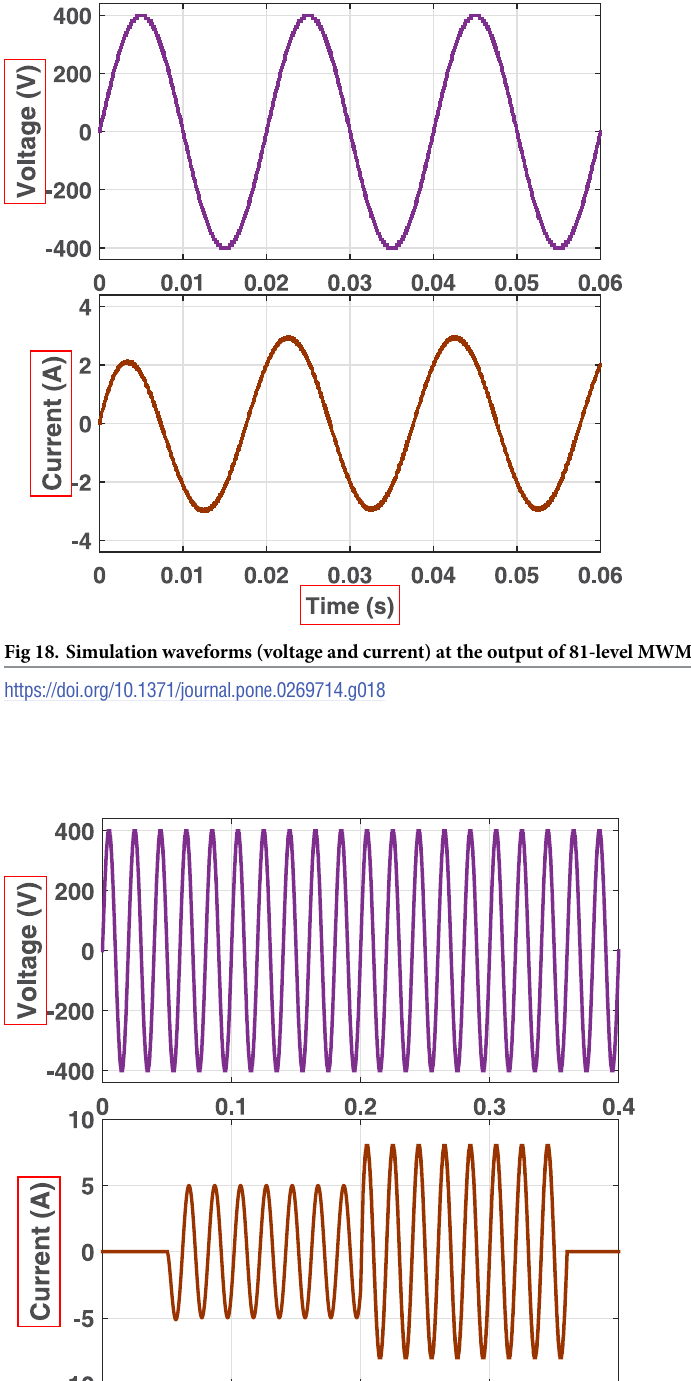
PLOS ONE | https://doi.org/10.1371/journal.pone.0269714 June 22,